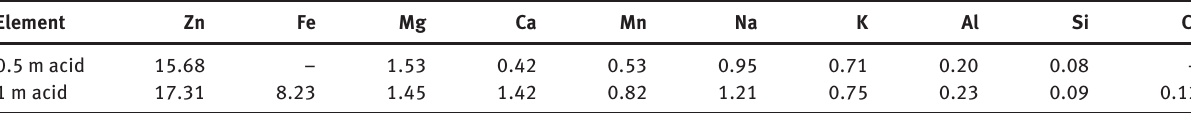
Table 1: X-ray fluorescence analysis of EAF dust. Element Fe wt.% Element wt.%